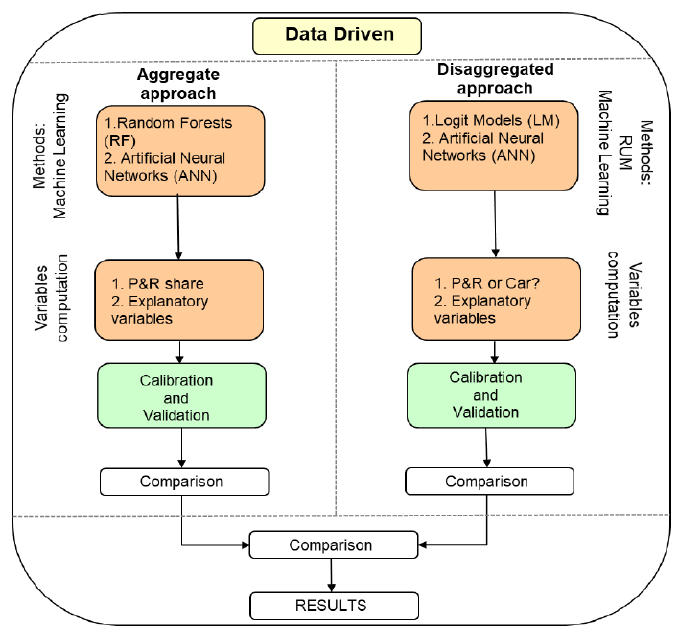
Figure 2. Methodological framework of multimodality models.